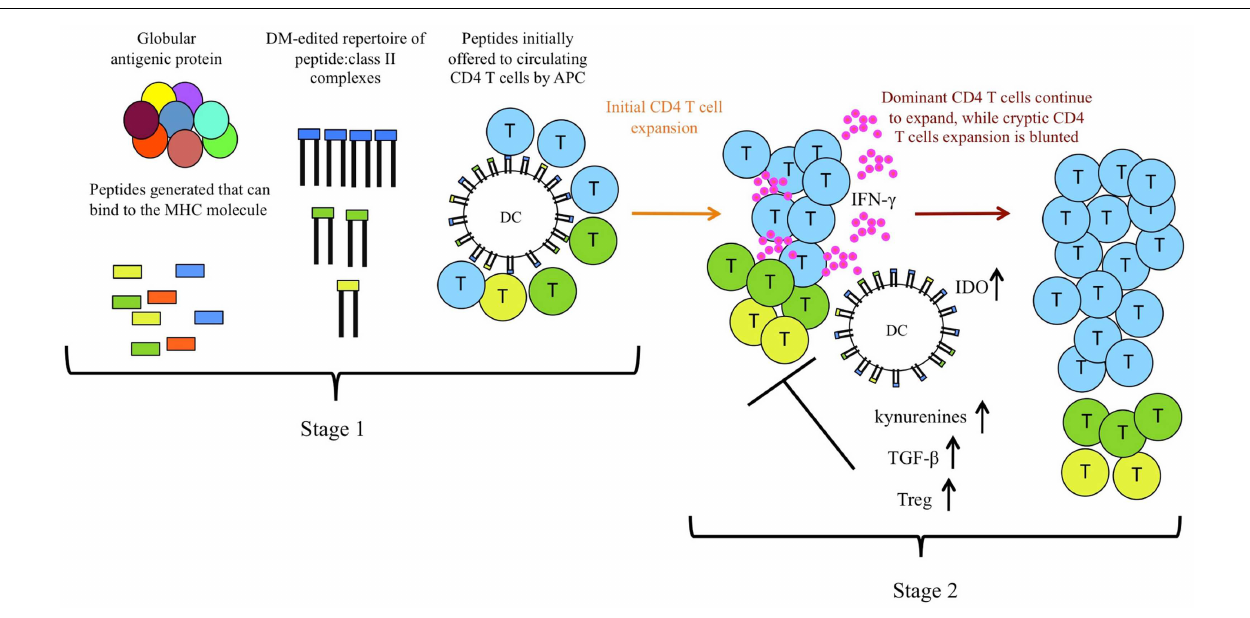
stage, or after multi-peptide immunization, regulatory events induced by dominant CD4T cells (indicated in blue), including production of IFN- γ , and resulting IDO andTreg induction and production of kynurenines further refine the CD4 repertoire by inhibiting full expansion of CD4T cells specific for lower stability complexes, indicated in yellow and